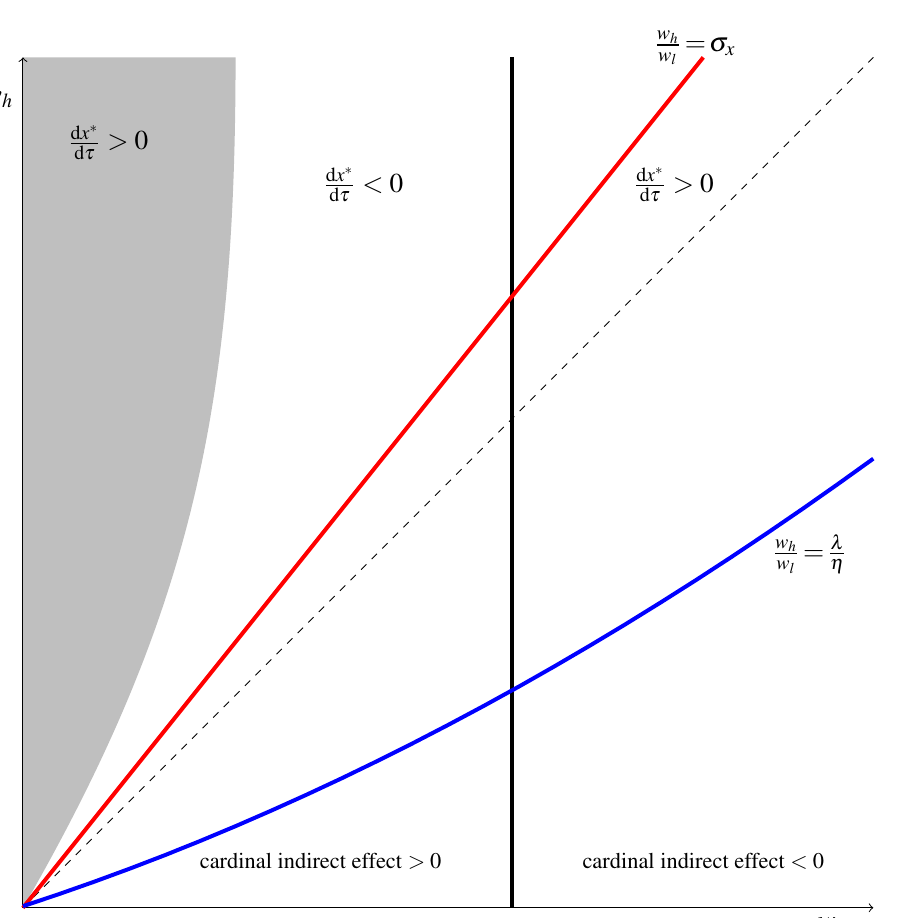
Figure 2: A case where the cardinal status direct effect is negative for every w h / w l , as implied by Result 5. The ordinal status effect is positive and when w h / w l > σ x , and for sufficiently high values of w h / w l more than offsets the cardinal status direct effect (the shaded area on the left). The sign of d x ∗ / d τ is obtained taking also into account the sign of cardinal status indirect